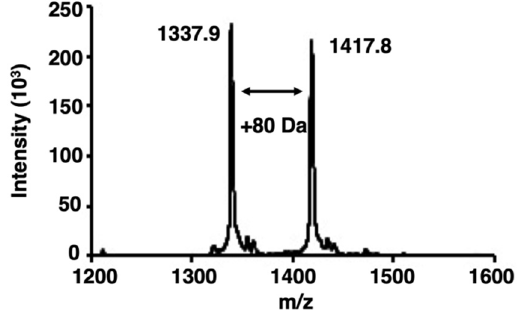
Figure 1. Matrix-assisted laser desorption/ionization–time-of-flight mass spectrometry (MALDI-TOF MS) spectra of phosphorylation by protein kinase C α (PKC α ). The spectra were obtained from the phosphorylation reaction of a PKC α -specific peptide substrate with the lysate of bladder cancer cells. The peak of the phosphorylated peptides showed an increase of 80 Da.